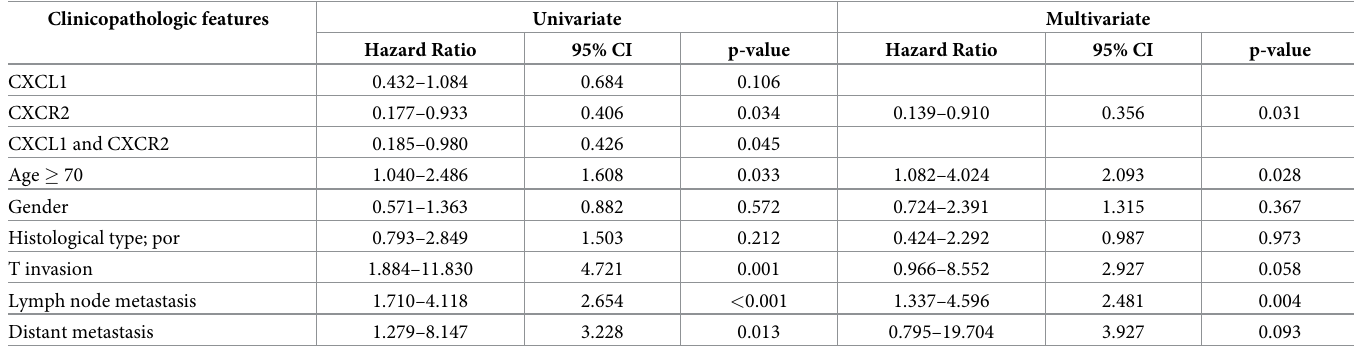
Table 2. Univariate and multivariate analysis with respect to overall